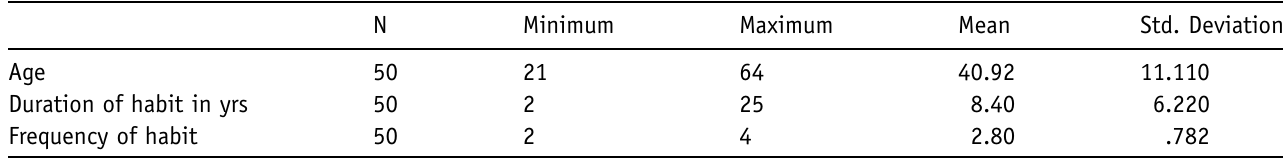
Table I. Showing mean & SD (descriptive statistics) of numerical variable.